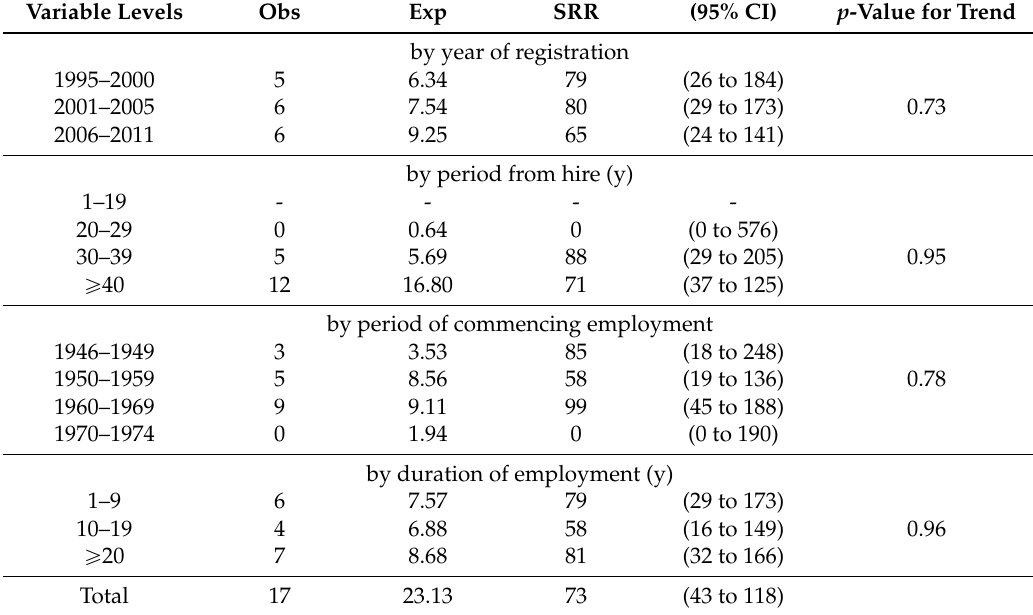
Table 1. Incidence of myelodysplastic syndrome (MDS) (ICD-10:D46) in 16,467 UK petroleum distribution workers, ages 15–84 years,